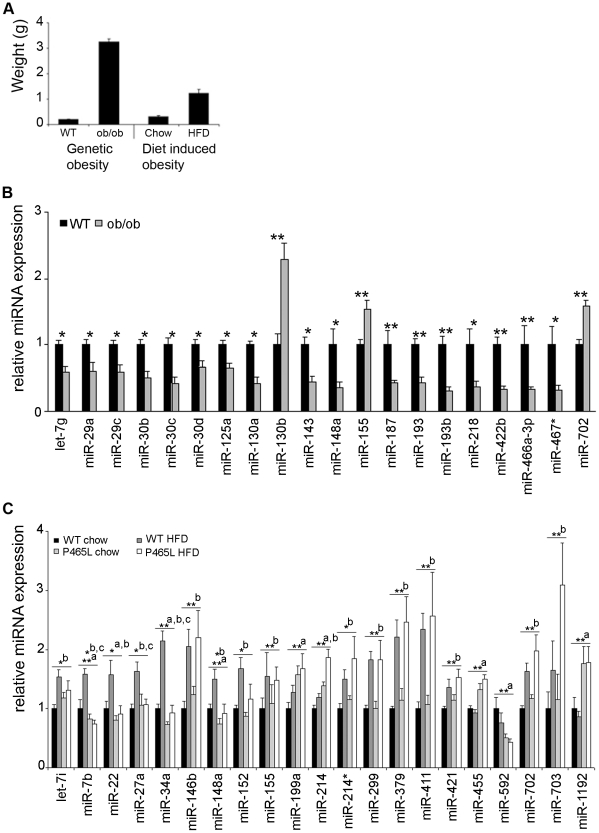
Differential expression of miRNAs in epididymal fat pads from mouse models of genetically or diet induced obesity.
A: Epididymal fat pad weights were compared of obese ob/ob mice and wild-type controls (Ob/ob model) and of wt or PPARγ DN mice fed either a chow or a high-fat diet (DIO model). B: miRNA levels were analyzed in epididymal fat pads from five wild-type (WT) and five leptin-deficient ob/ob mice by real-time-PCR. Data were normalized to SNORA73A expression. The relative expression levels compared to wild-type mice were plotted and significance was calculated using student's t-test. * p<0.05 ; **p<0.01 C: For the diet induced obesity model, miRNA expression in epididymal fat pads from chow or high fat diet fed wild-type as well as from PPARγ DN (P465L) mice was determined by real-time PCR. Five mice were analyzed for each condition. Data were normalized to SNORA73A expression and plotted as relative expression levels compared to wild-type normally fed mice. Anova tests revealed significantly regulated miRNAs * p<0.05 ; **p<0.01 and influence of genome (a), diet (b) or interaction of both (c).